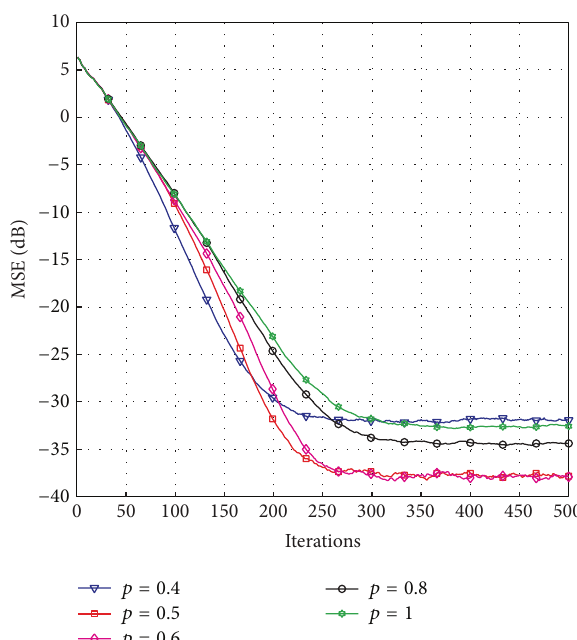
Figure 5: Effects of affine projection order 𝑄 on the proposed LP-